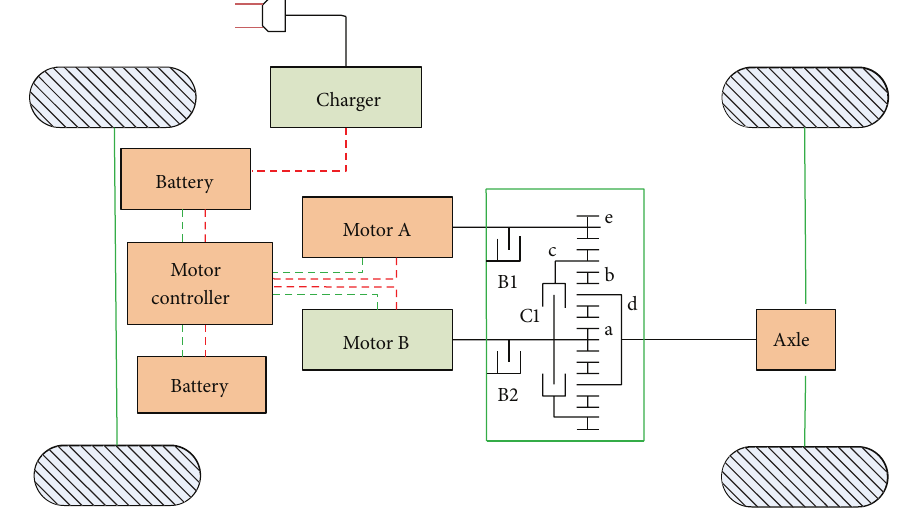
Figure 1: Overall structure.